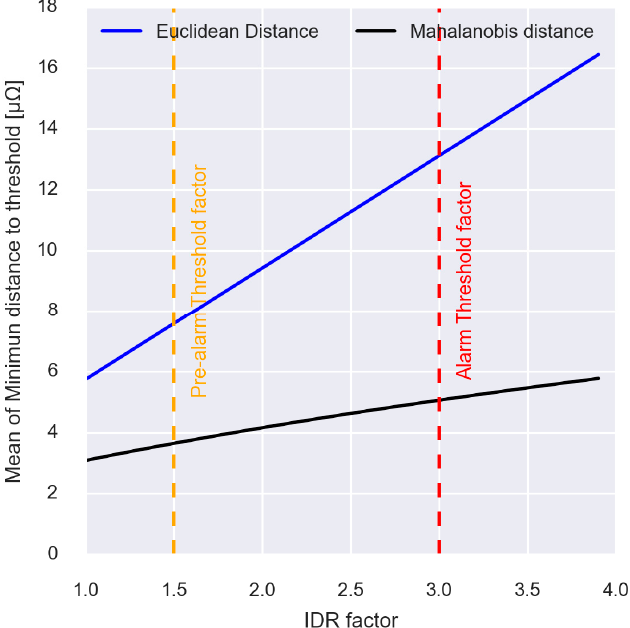
Figure 9. Comparison of the average minimum distance between the points and the closest threshold for the Euclidean distance and the Mahalanobis distance.